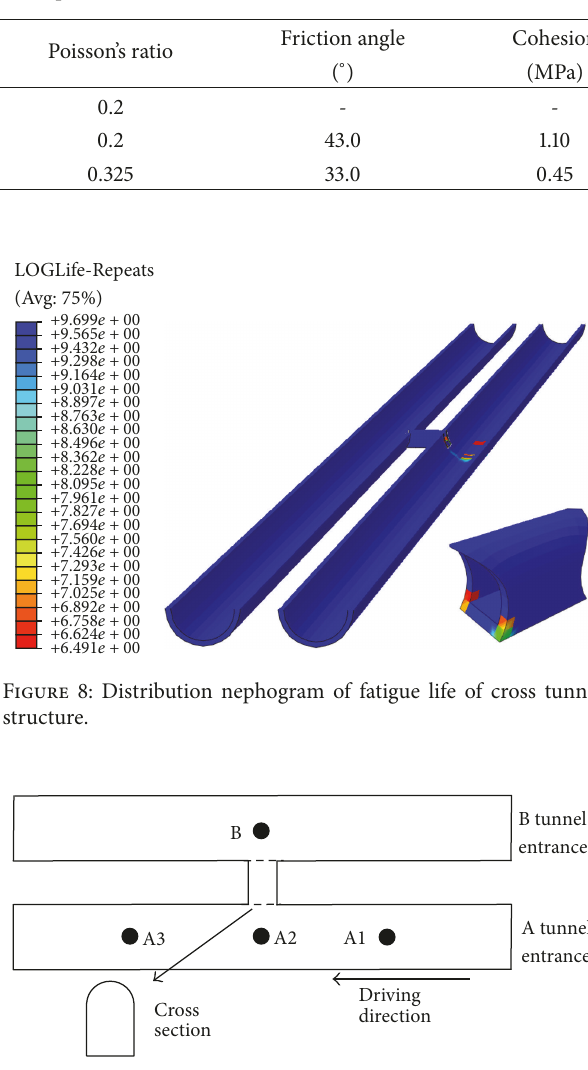
Figure 9: Diagram of tunnel analysis